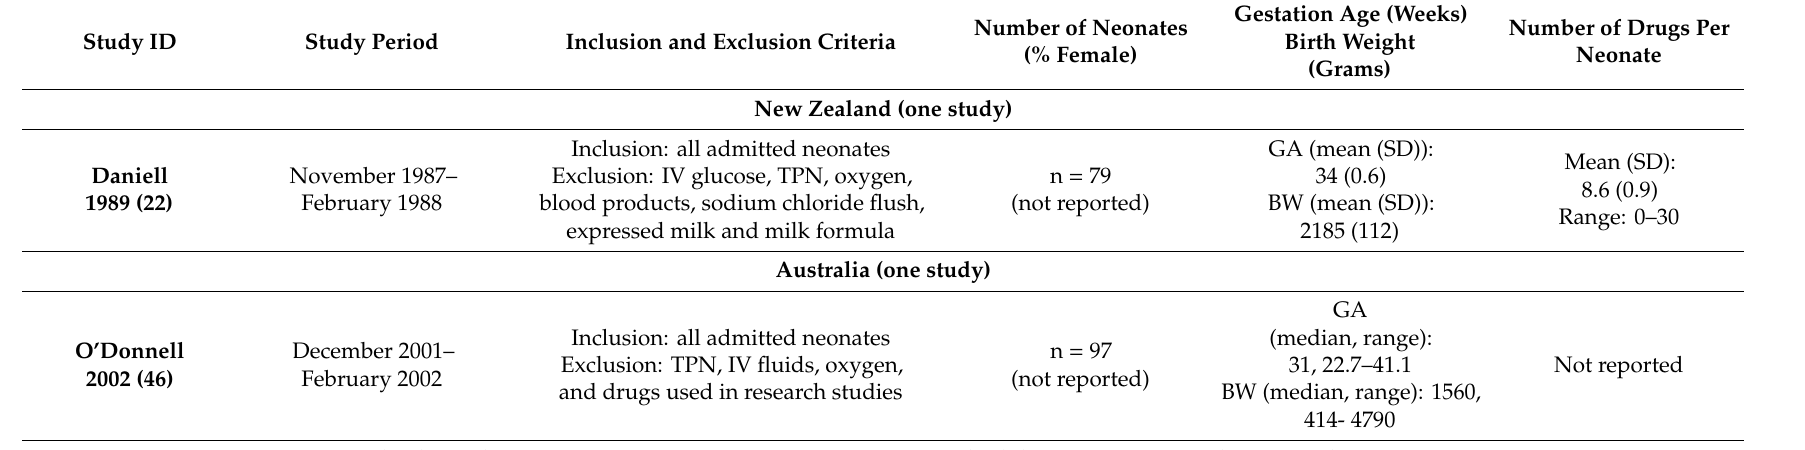
Table A7. Studies of drug utilization in Australasia (2